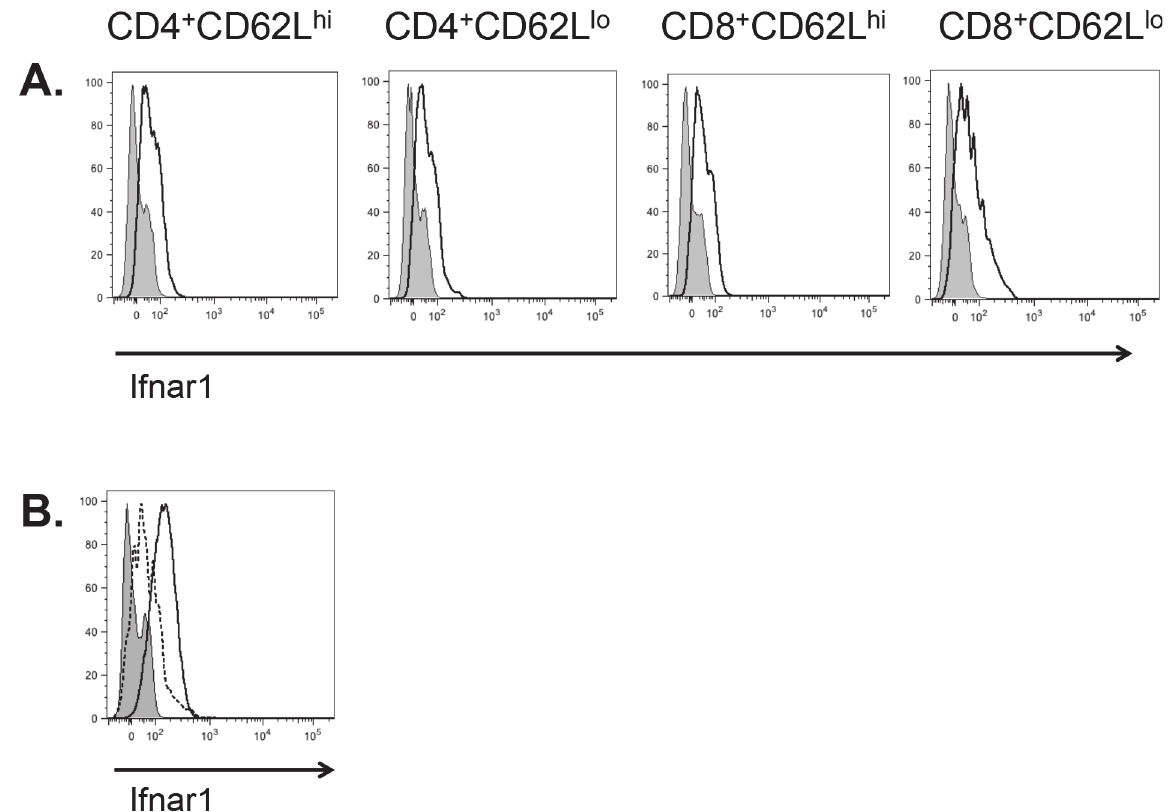
Fig 1. Th1 cells express the type I interferon receptor. A. Na ï ve (CD62L hi ) and effector (CD62L lo ) CD4 + and CD8 + C57BL/6J T cells were assessed for surface expression of Ifnar1 by flow cytometry. Open histogram, Ifnar1; shaded histogram, fluorescence minus one (FMO) control. B. Th1 and Th17 cells were cultured and assessed for surface expression of Ifnar1 after 5 days. Solid line with open histogram, Th1; Dotted line with open histogram, Th17; shaded histogram, FMO control. Data representative of one of three experiments.